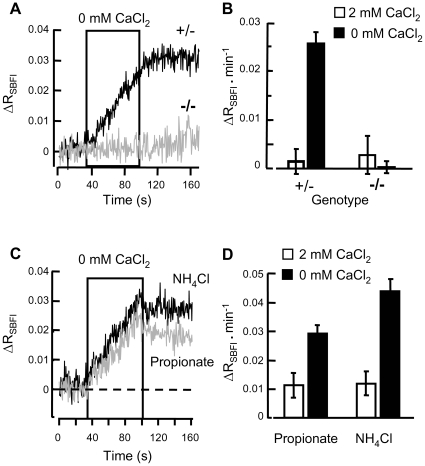
Evoked [Na+]i rise requires CatSper2.Responses of the SBFI probe monitored from small clusters of CatSper2-null sperm (gray trace, −/−) and of sperm from their heterozygous littermates (black trace, +/−). (A) Cells were perfused first with medium HS, then for 60 s (boxed) with Ca2+-deficient HS. Lines are averages of normalized ΔRSBFI data. (B) Averaged rate of change in ΔRSBFI before and during perfusion with Ca2+-deficient HS medium (49–50 cell clusters in 3 independent experiments). (C) Wild-type sperm were perfused with medium HS then for 60 s (boxed) with Ca2+-deficient HS, both fortified with 15 mM NH4Cl (black traces) or 15 mM Na propionate (gray traces). (D) Averaged normalized rates of rise of ΔRSBFI (9–14 groups of cells in 3 independent experiments).